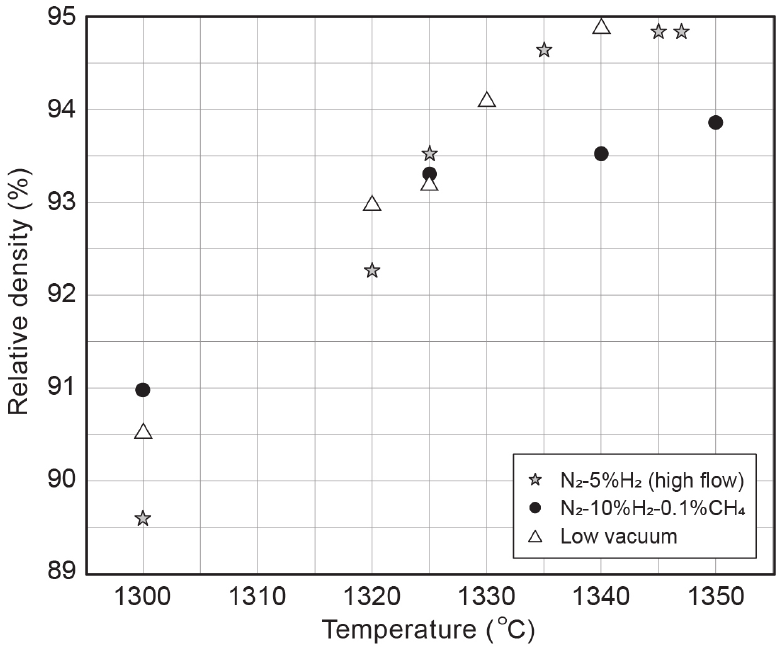
Figure 7. Relative density as a function of sintering temperature at 1 h of holding time